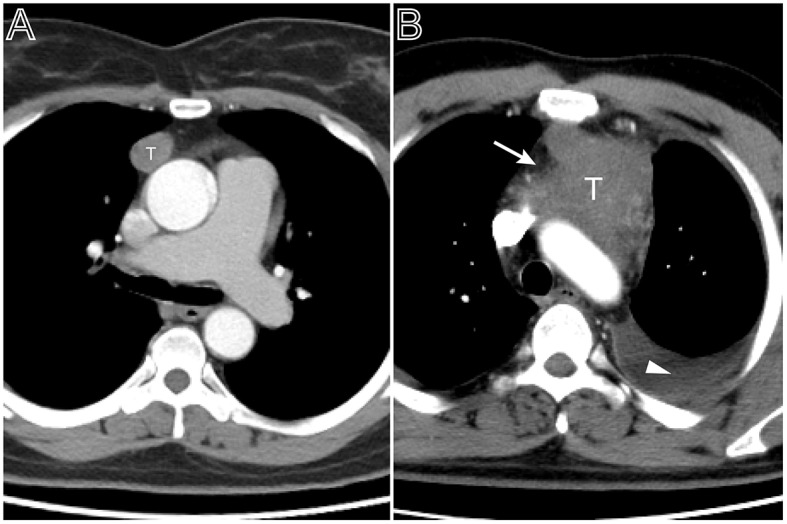
Tumor size and pleural effusion are associated with patient's symptoms. (A) Axial contrast-enhanced chest CT image obtained at the level of the aortic arch showed a small thymoma with a smooth contour (Masaoka–Koga stage I and WHO classification A), which was first found at the time of physical examination in a 49-year-old woman. (B) A 53-year-old man with chief complains of cough, chest pain symptoms. Axial contrast-enhanced chest CT image obtained at the level of below the aortic arch showed a larger thymoma with lobulated contour and infiltration of surrounding fat (arrows), accompanied with left pleural effusion (Masaoka–Koga stage III and WHO classification B2).